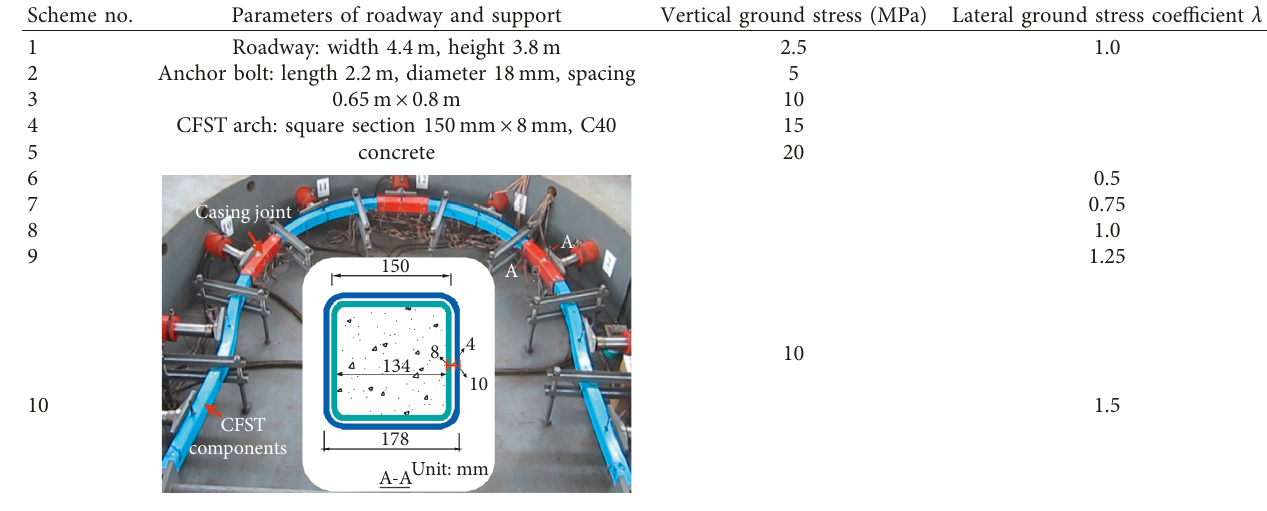
Table 1: Test schemes.